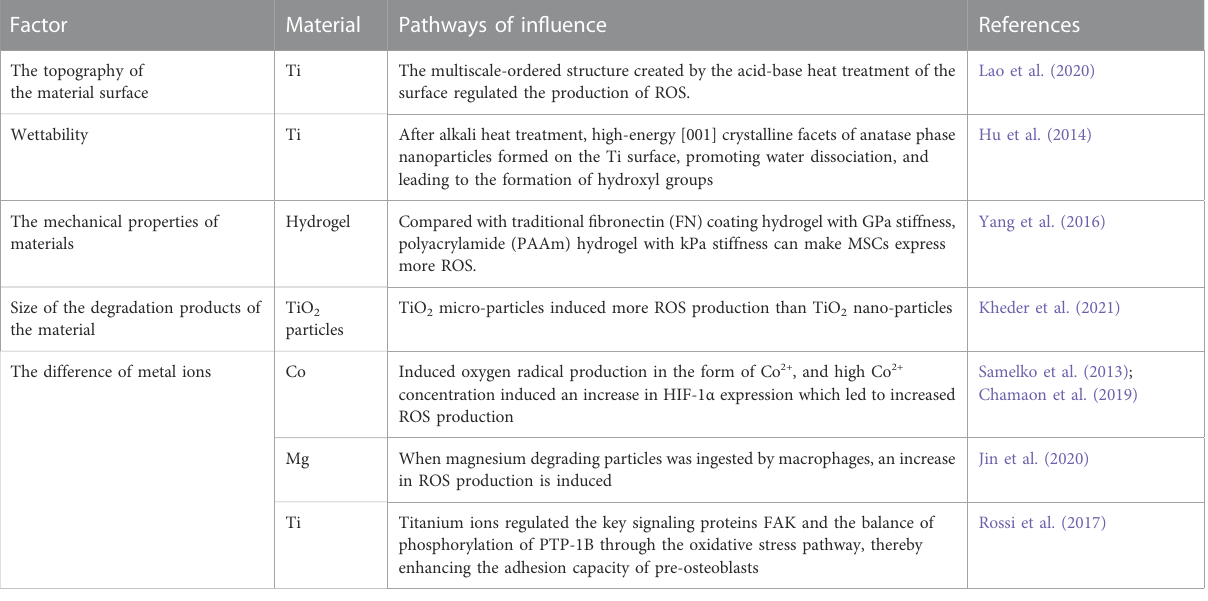
TABLE 1 Material factors affecting oxidative stress.